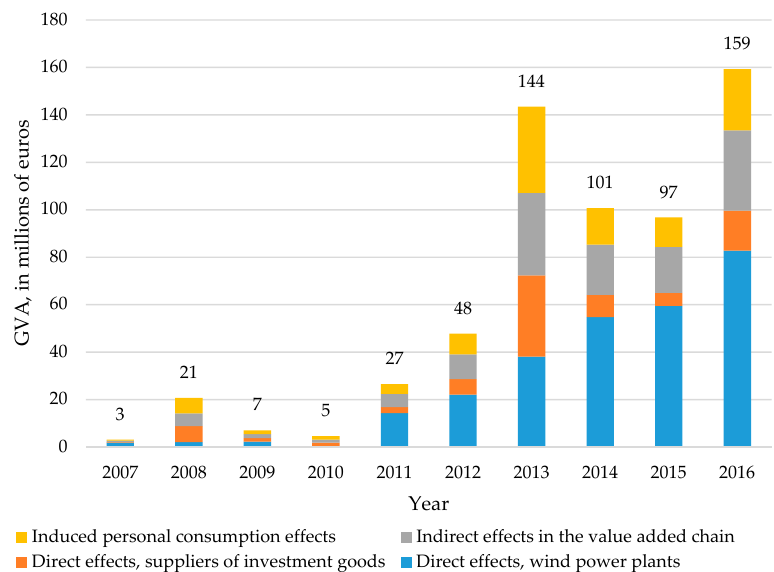
Figure 1. Gross value added (GVA) induced by wind power plants deployment and operation in Croatia, in millions of euros. Energies 2018 , 11 , x FOR PEER REVIEW